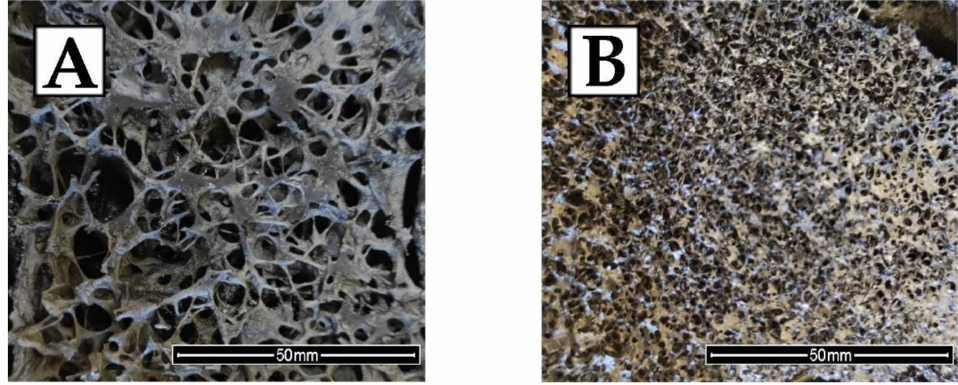
Figure 5. RPU/PIR foams after combustion in a cone calorimeter: ( A ) EPC0 foam; ( B ) EPC50